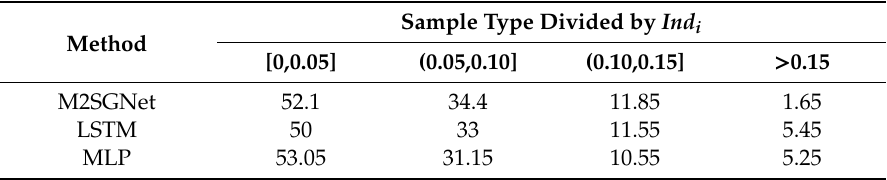
Table 3. Sample Ratio of Di ff erent Category